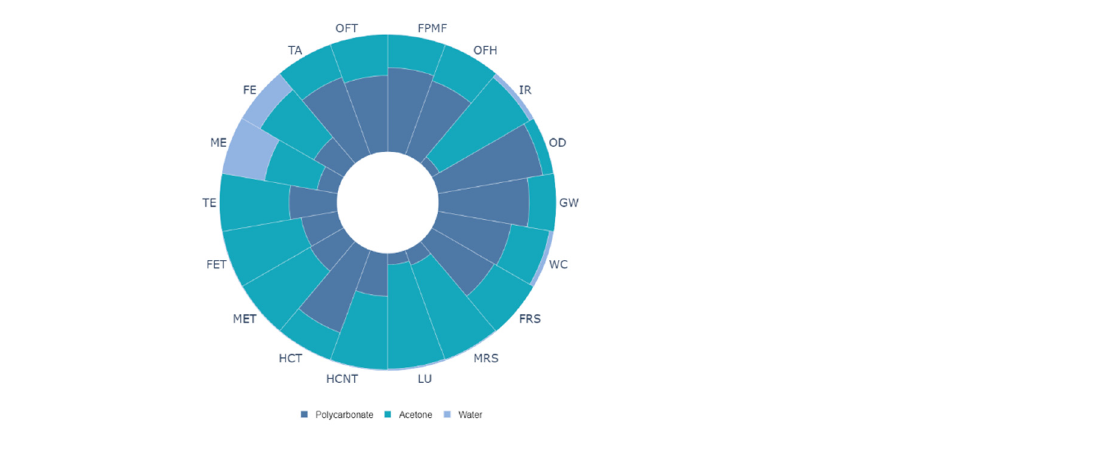
Figure 11. Normalized cradle-to-gate environmental profile for the hydrophobizing process. Here, GW is global warming, OD is stratospheric ozone depletion, IR is ionizing radiation, OFH is ozone formation, human health, FPMF is fine particulate matter formation, OFT is ozone formation, ter- restrial ecosystems, TA is terrestrial acidification, FE is freshwater eutrophication, ME is marine eutrophication, TE is terrestrial ecotoxicity, FET is freshwater ecotoxicity, MET is marine ecotoxicity, HCT is human carcinogenic toxicity, HCNT is human non-carcinogenic toxicity, LU is land use, MRS is mineral resource scarcity, FRS is fossil resource scarcity, and WC is water consumption.